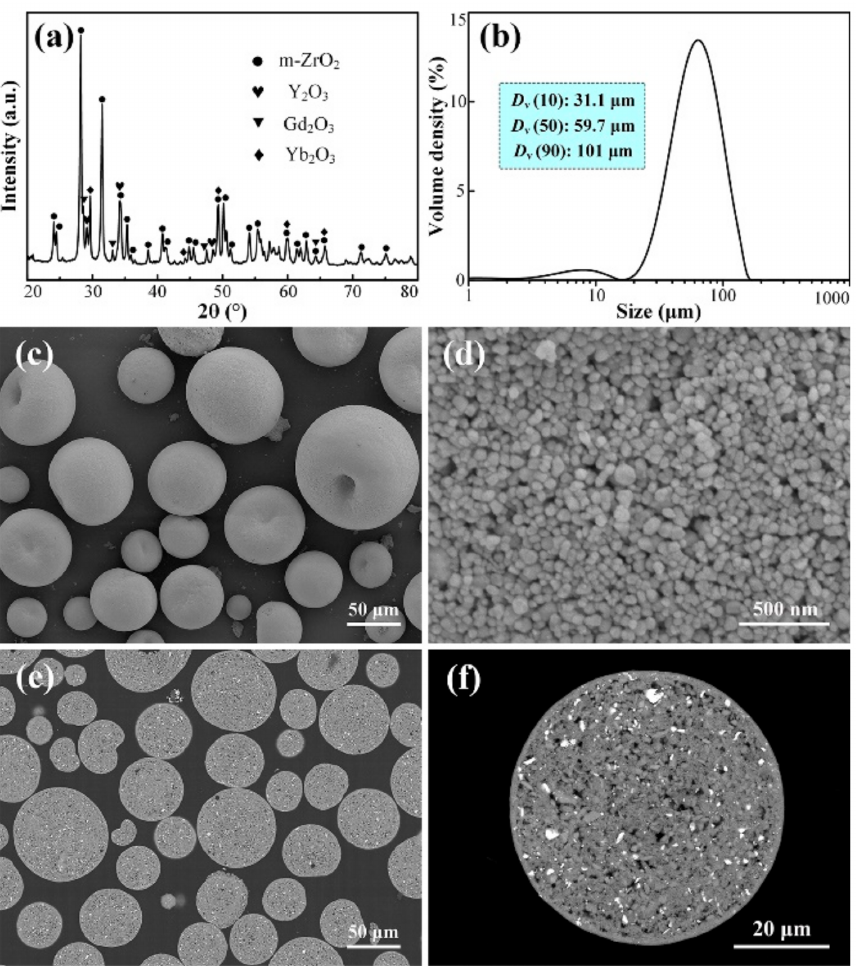
Figure 2. XRD pattern ( a ), particle size distribution ( b ), surface morphologies ( c , d ) and cross-sectional microstructures ( e , f ) of 10YGYZ agglomerated powders. ( d , f ) Show enlarged SEM images of the surface and cross section of a single powder,